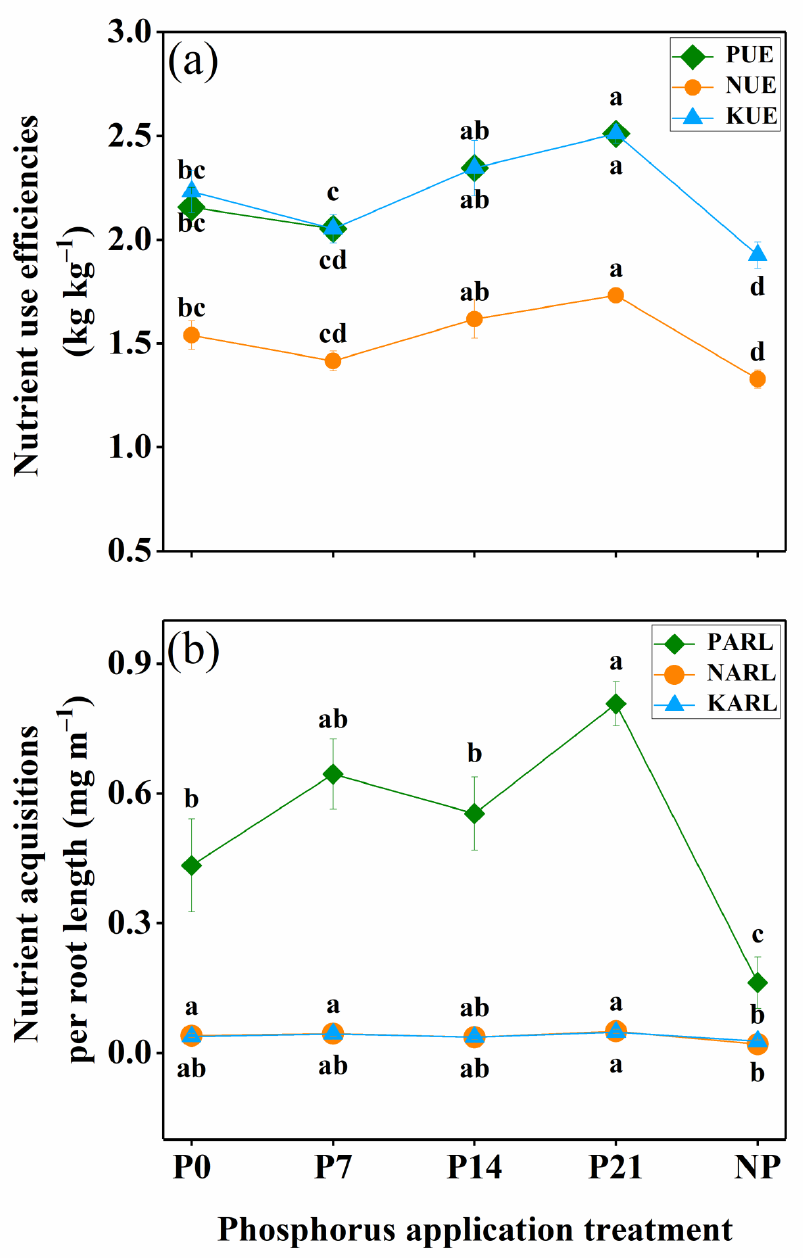
Figure 5. Nutrient use efficiencies and nutrient acquisitions per root length as a function of P application time: ( a ) Nutrient use efficiency (P use efficiency (PUE), N use efficiency (NUE), and K use efficiency (KUE) and ( b ) nutrient acquisition per root length (P acquisition per root length (PARL), N acquisition per root length (NARL) and K acquisition per root length (KARL). P0 means P application at planting; P7 means P application at 7 d after planting; P14 means P application at 14 d after planting; P21 means P application at 21 d after planting; and NP means no P application. Different lowercase letters mean significant differences in nutrient use efficiencies and nutrient acquisitions per root length among different treatments at p < 0.05, n =